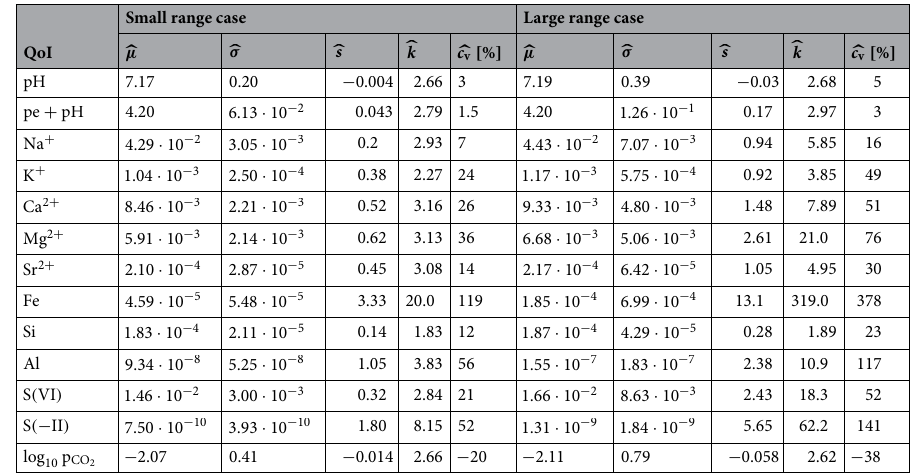
Table 4. Empirical mean 6 estimated with 10 realizations of the surrogate